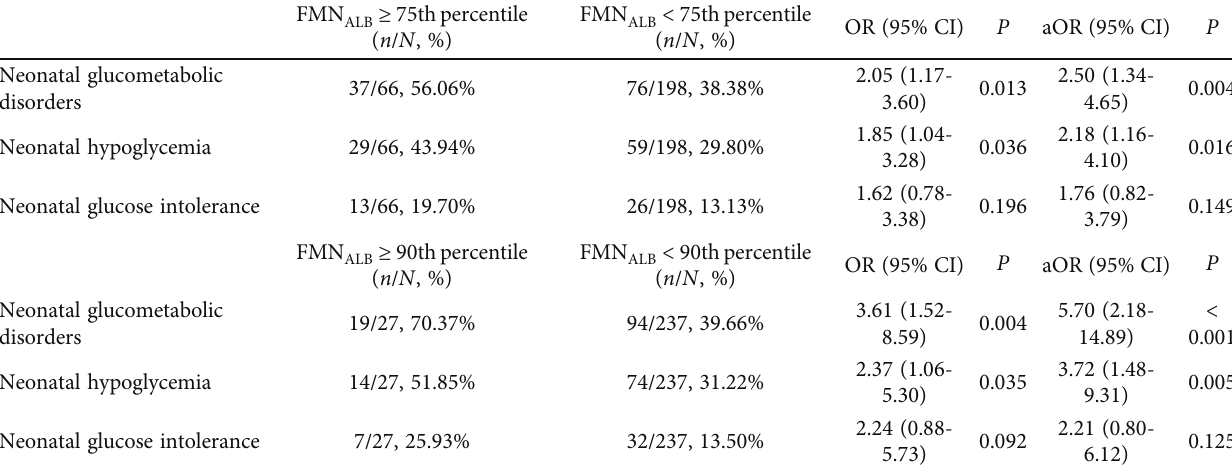
before delivery and neonatal glucometabolic disorders. ALB